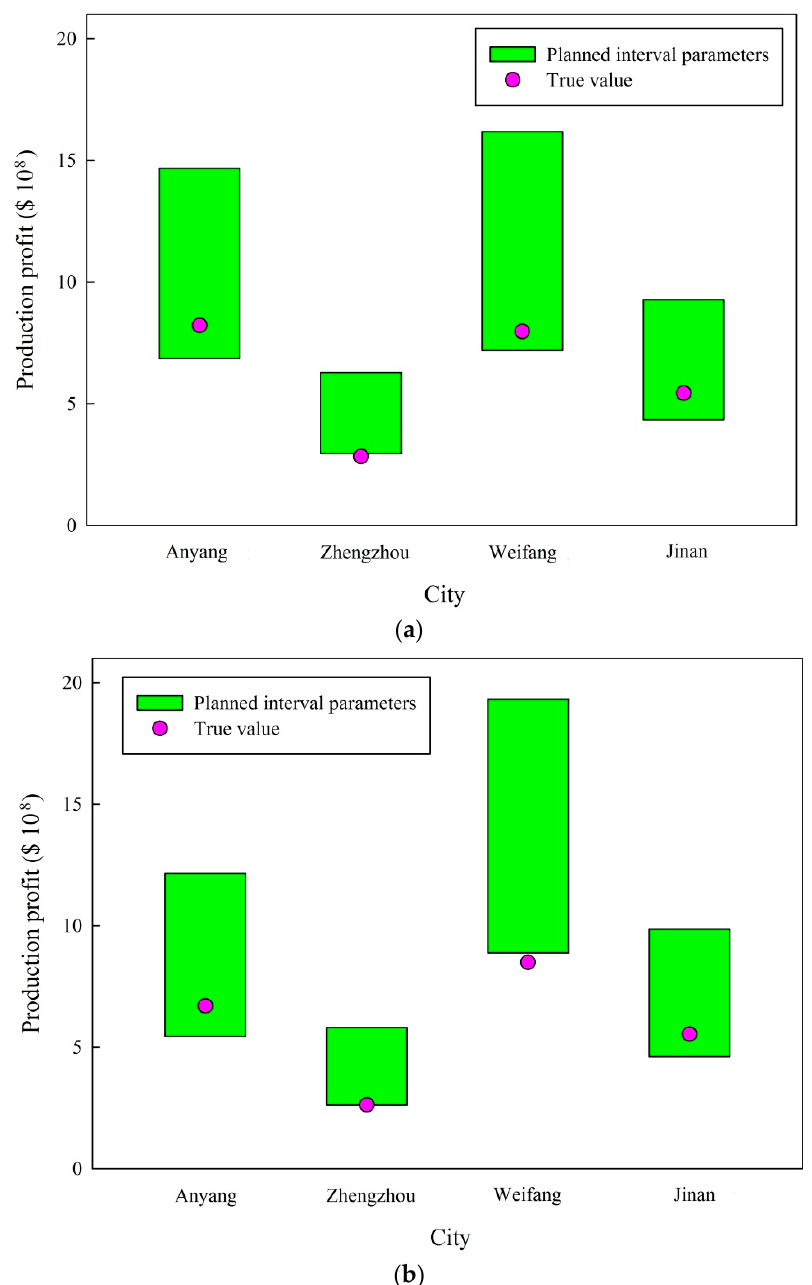
Figure 8. The comparison of planned interval parameters and true value of profit in 2020. ( a ) Winter wheat in 2020 and ( b ) summer corn in 2020.